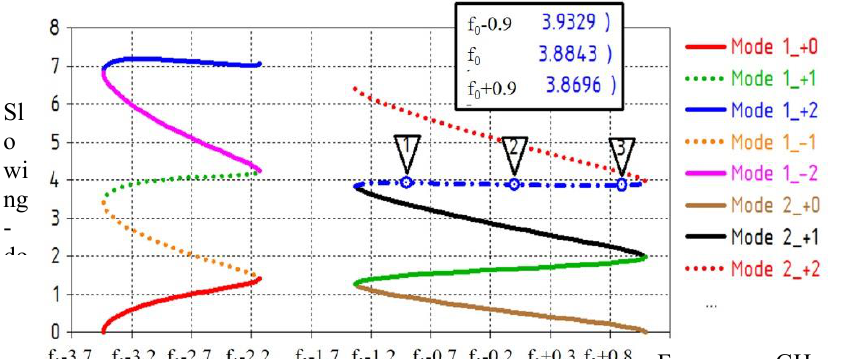
Fig. 2. Slowing-down factor versus frequency.